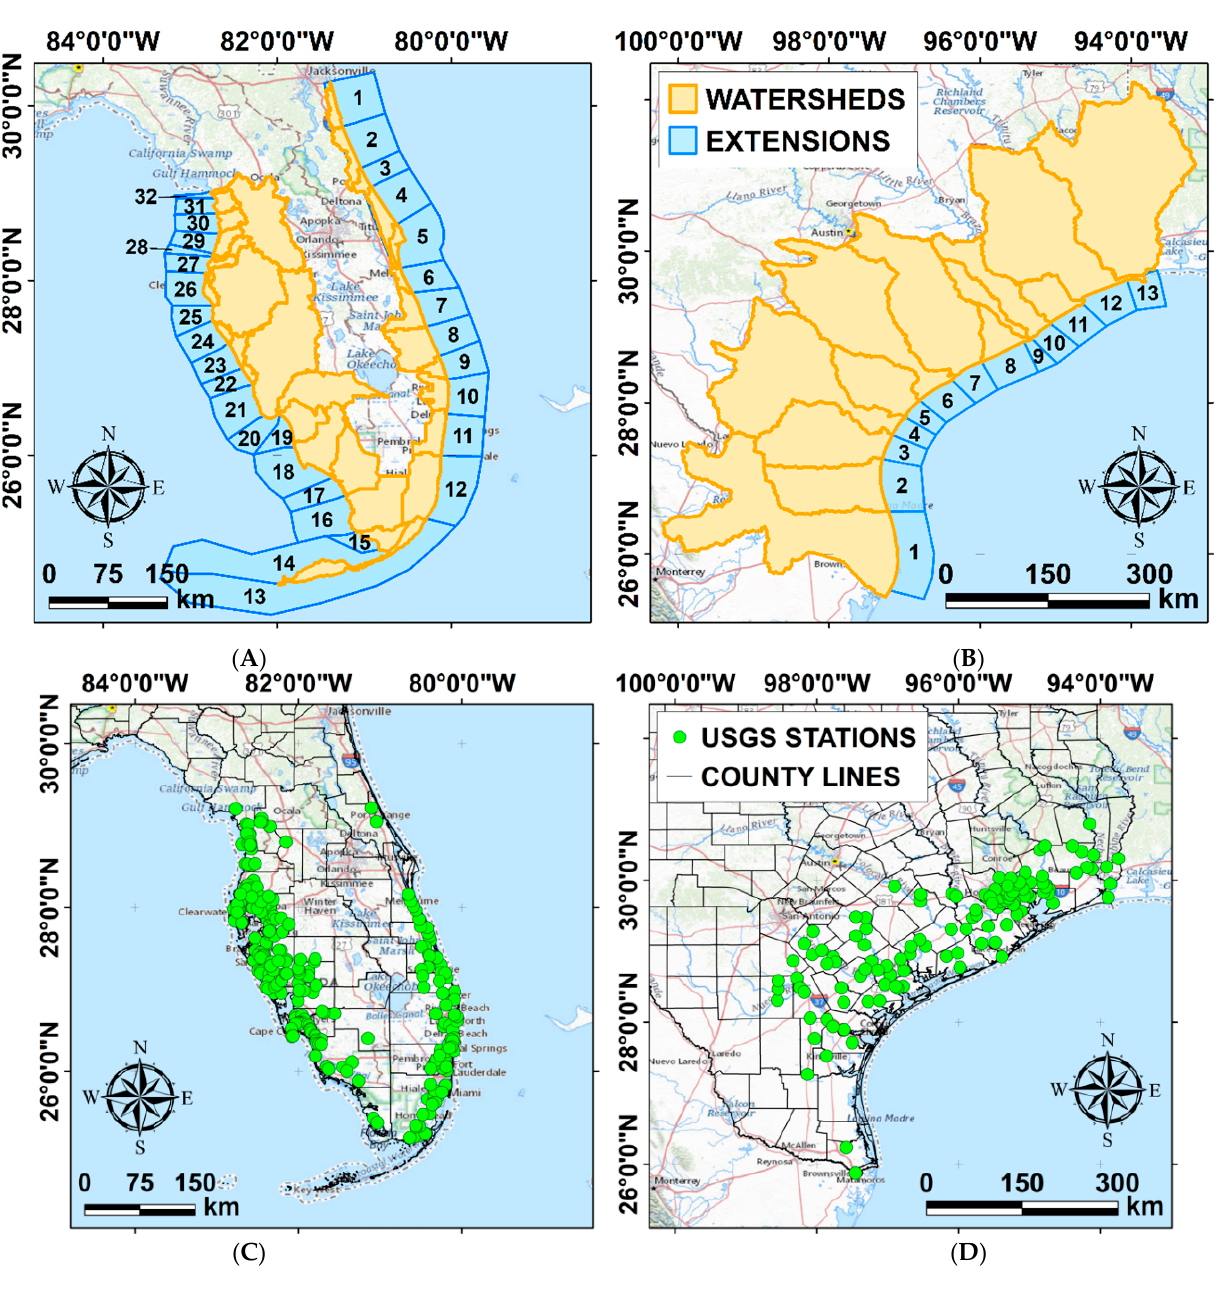
Figure 3. Distribution of the watersheds we identified in the study areas to divide the riverine water quality data and the population densities (orange polygons), and the areas we considered for the extraction of the environmental data from the HYCOM hydrostatic circulation model (blue polygons) in Florida ( A ) and Texas ( B ). Distribution of the USGS stations (green dots) in Florida ( C ) and Texas ( D ), where data was available in the considered timeframe (see Figure 1). Table 1. Water quality and hydrodynamics predictor variables contained in the table were used in the linear regression analysis to find a relationship with the FP prevalence values. The columns contain, in order, the name, the source, and the unit of measurement (U.M.) of the predictors.